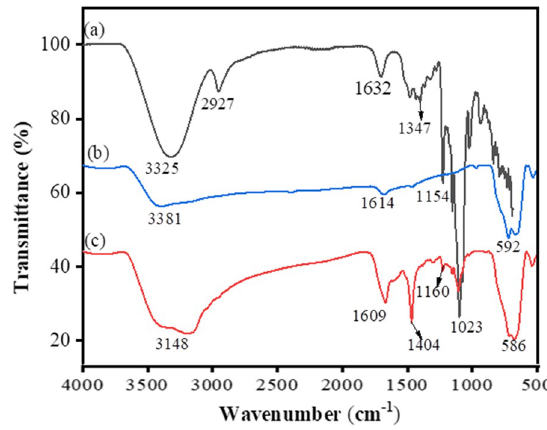
Fig. 1 FTIR spectra of (a) β-cyclodextrin, (b) bare Fe 3 O 4 , and (c)